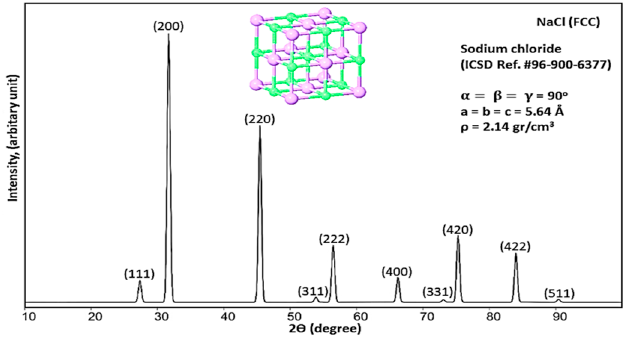
Figure 6. X-ray diffraction of NaCl powder sample. Table 3. Crystallographic parameters of the NaCl (FCC) structure resulting from the X’Pert software.